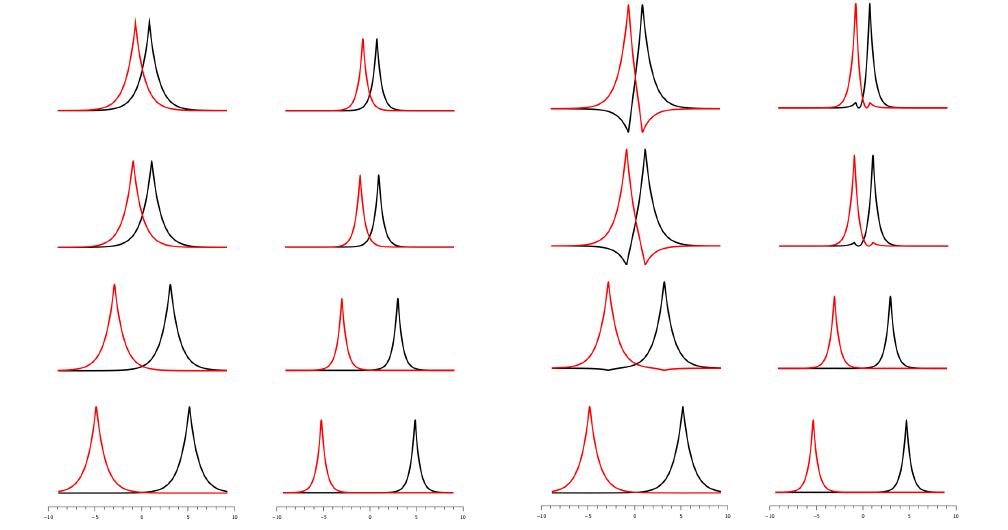
Figure 24. ( Left ) Shape of the 1s AOs and squared AOs for different atom distances; ( right ) shape of the 1s orthonormalized AOs (OAOs) and squared OAOs for different atom